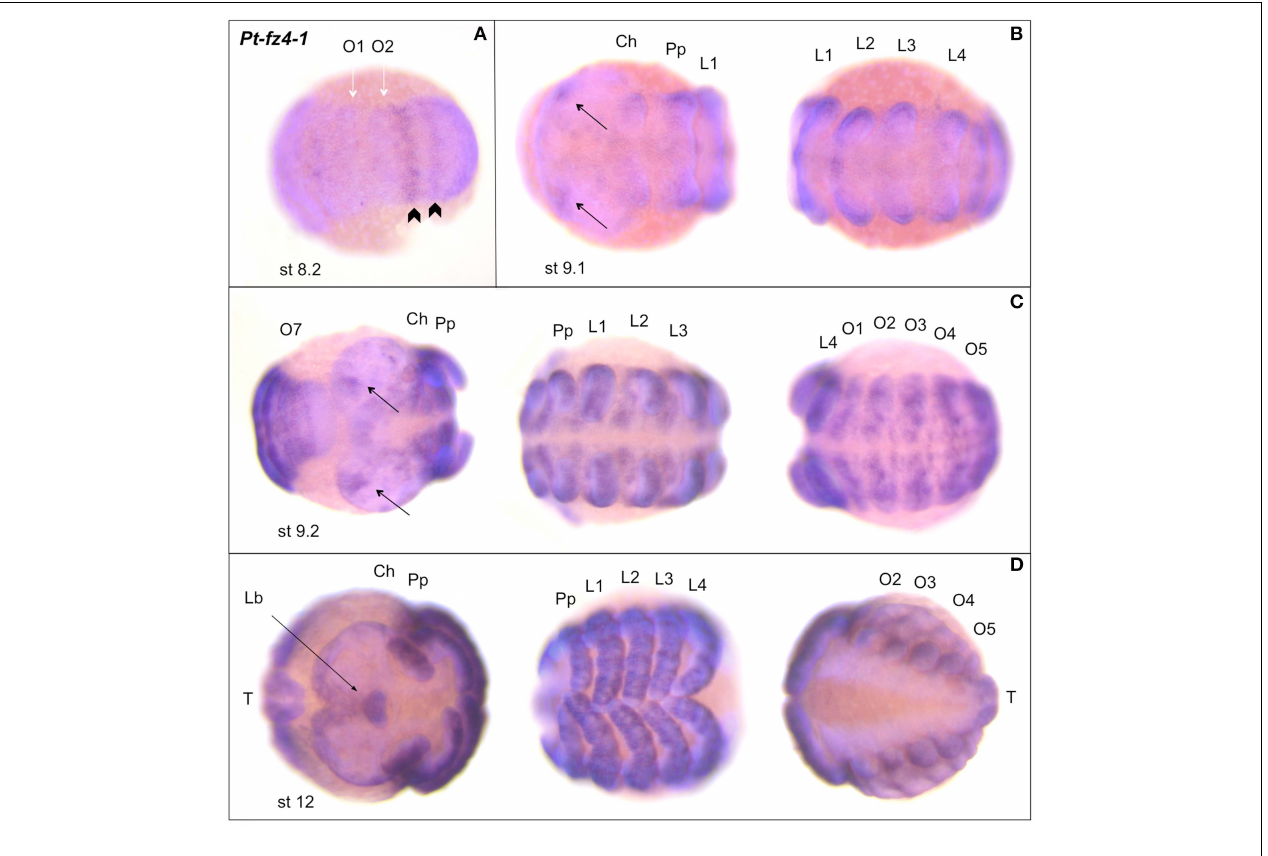
germ band (anterior prosoma, posterior prosoma, opisthosoma). The white arrows in (A) indicate the O1 and O2 segments; the black arrowheads mark Pt-fz4-1 expression in O2 and the SAZ. Developmental stages are indicated. Abbreviations as in Figure 6 . Lb, labrum; T,